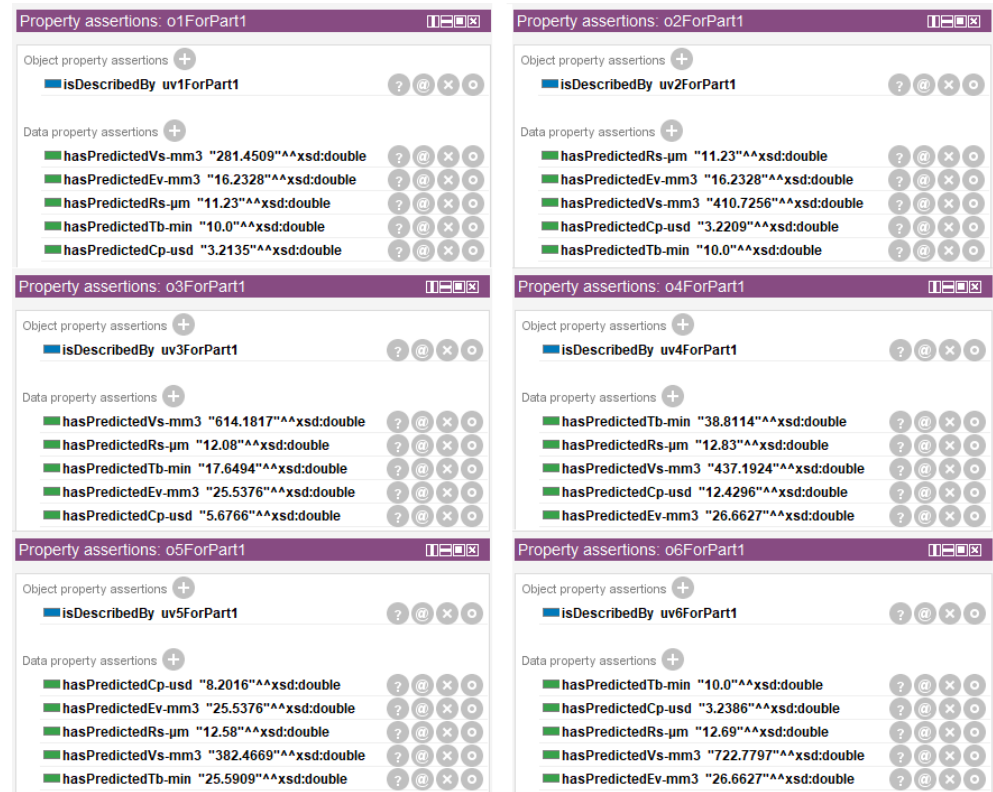
Figure 10. Predicted factor values under the six alternative orientations of Part 1.